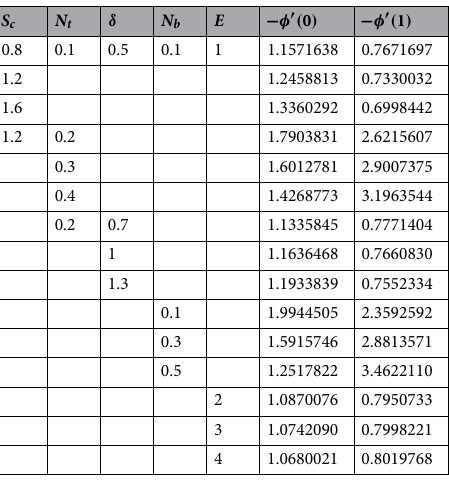
Table 4. Computational values of the rate of mass transfer for different estimations of S c , N t , δ , N b and E at both walls.